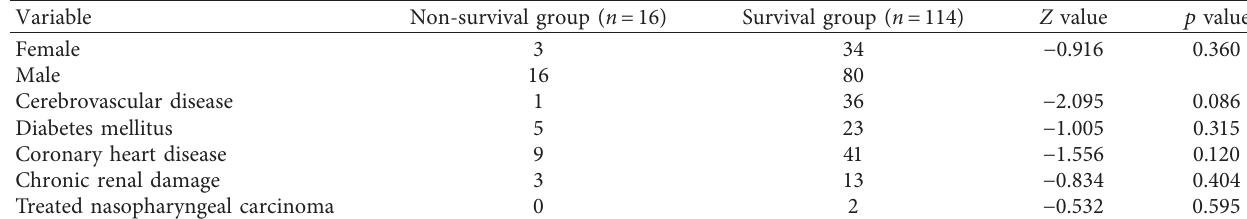
Table 4: Gender and comorbidities between survival and nonsurvival